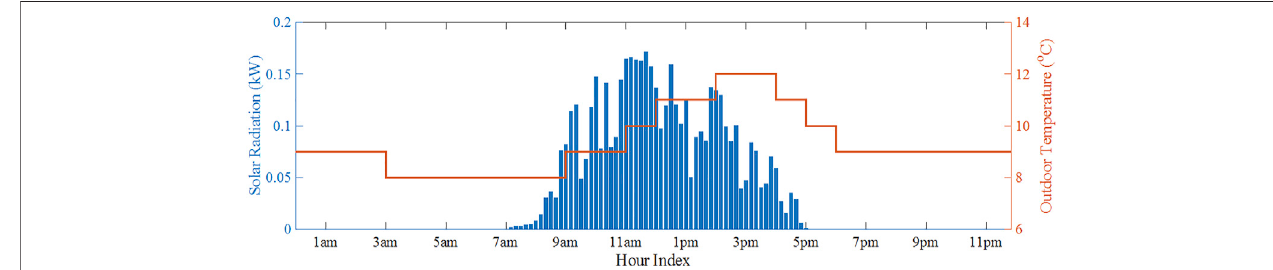
FIGURE 8 | Pro fi les of outdoor temperatures and solar radiation in a typical winter day.